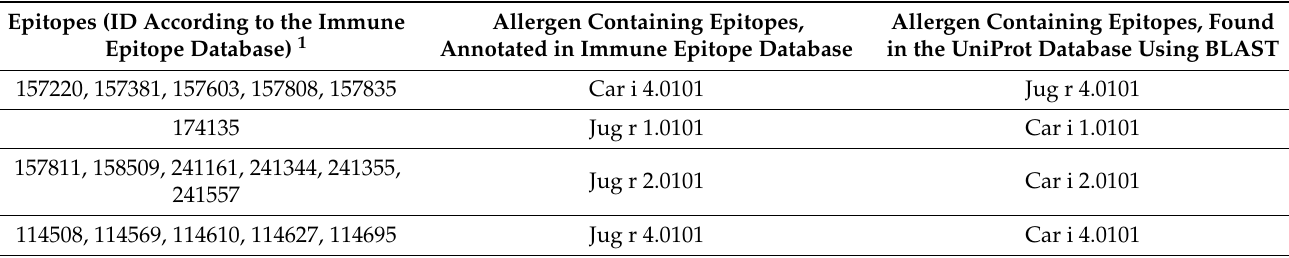
Table 2. Interspecies share of linear epitopes between proteins from C. illinoinensis and J. regia . Epitopes (ID According to the Immune Allergen Containing Epitopes, Allergen Containing Epitopes, Epitope Database) 1 Annotated in Immune Epitope Database